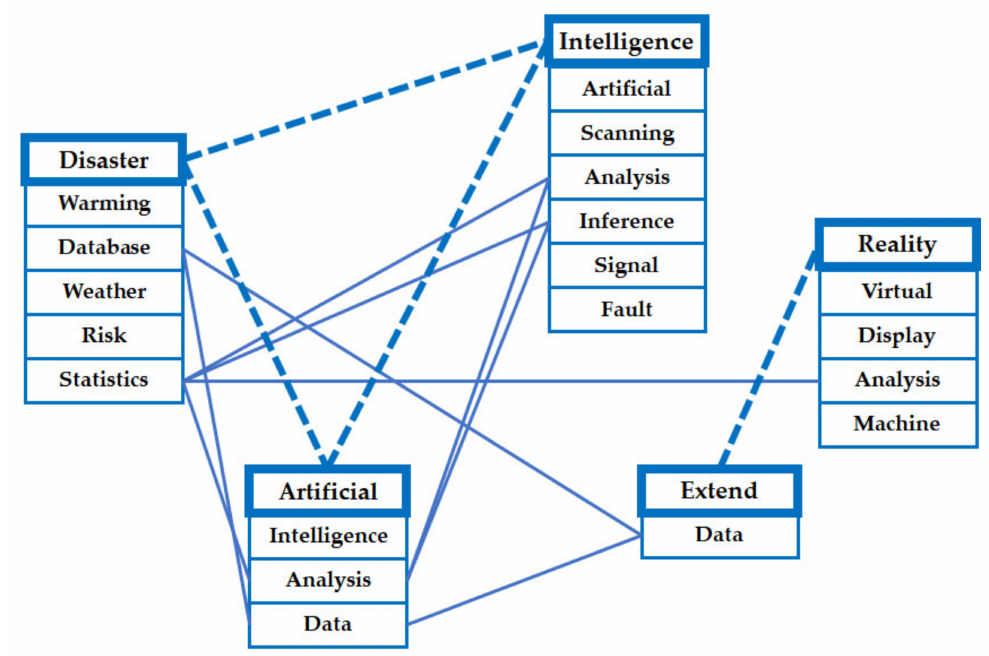
Figure 10. Integrated technology diagram for disaster AI and XR.